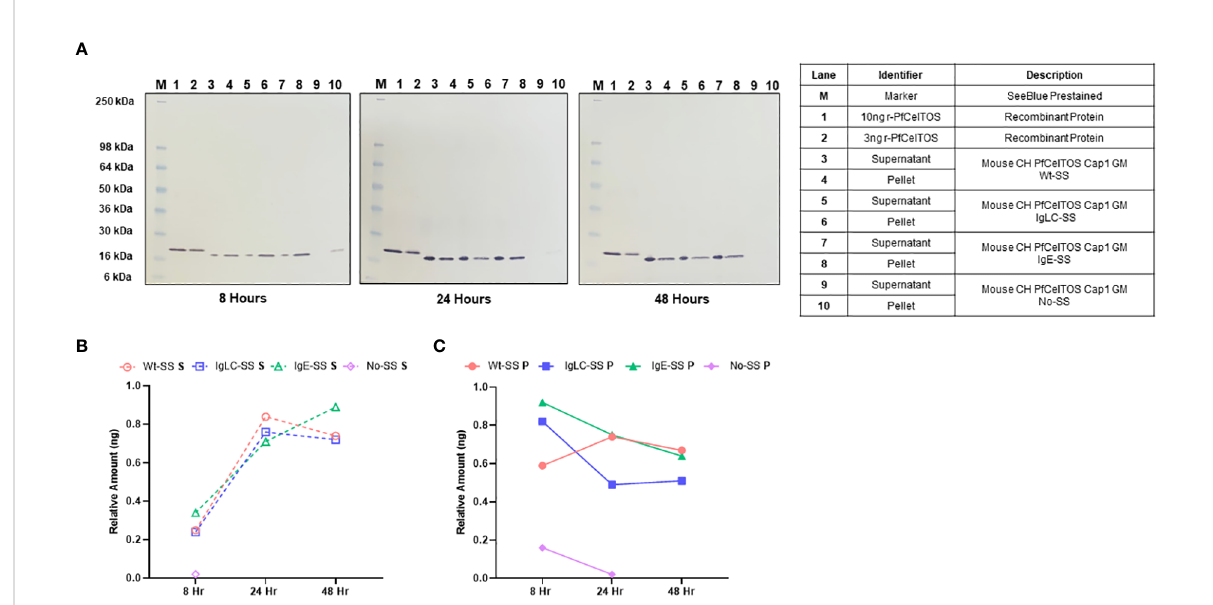
FIGURE 1 In vitro translation of pfceltos mRNAs with different signal sequences. (A) CHO cells were transfected with pfceltos mRNAs, having identical non-coding and coding sequences except for the signal sequences, and harvested at 8-, 24-, and 48-hours post-transfection. Western blot analysis was performed to assess for in vitro translation and translocation of PfCelTOS. The right panel outlines each lane and provides a detailed description of the test samples. Semi-quantitative analysis of the PfCelTOS protein levels at the different time points was performed by using ImageJ for the (B) supernatant and (C) cell lysate relative to the 10ng recombinant PfCelTOS protein (Lane 1, for each